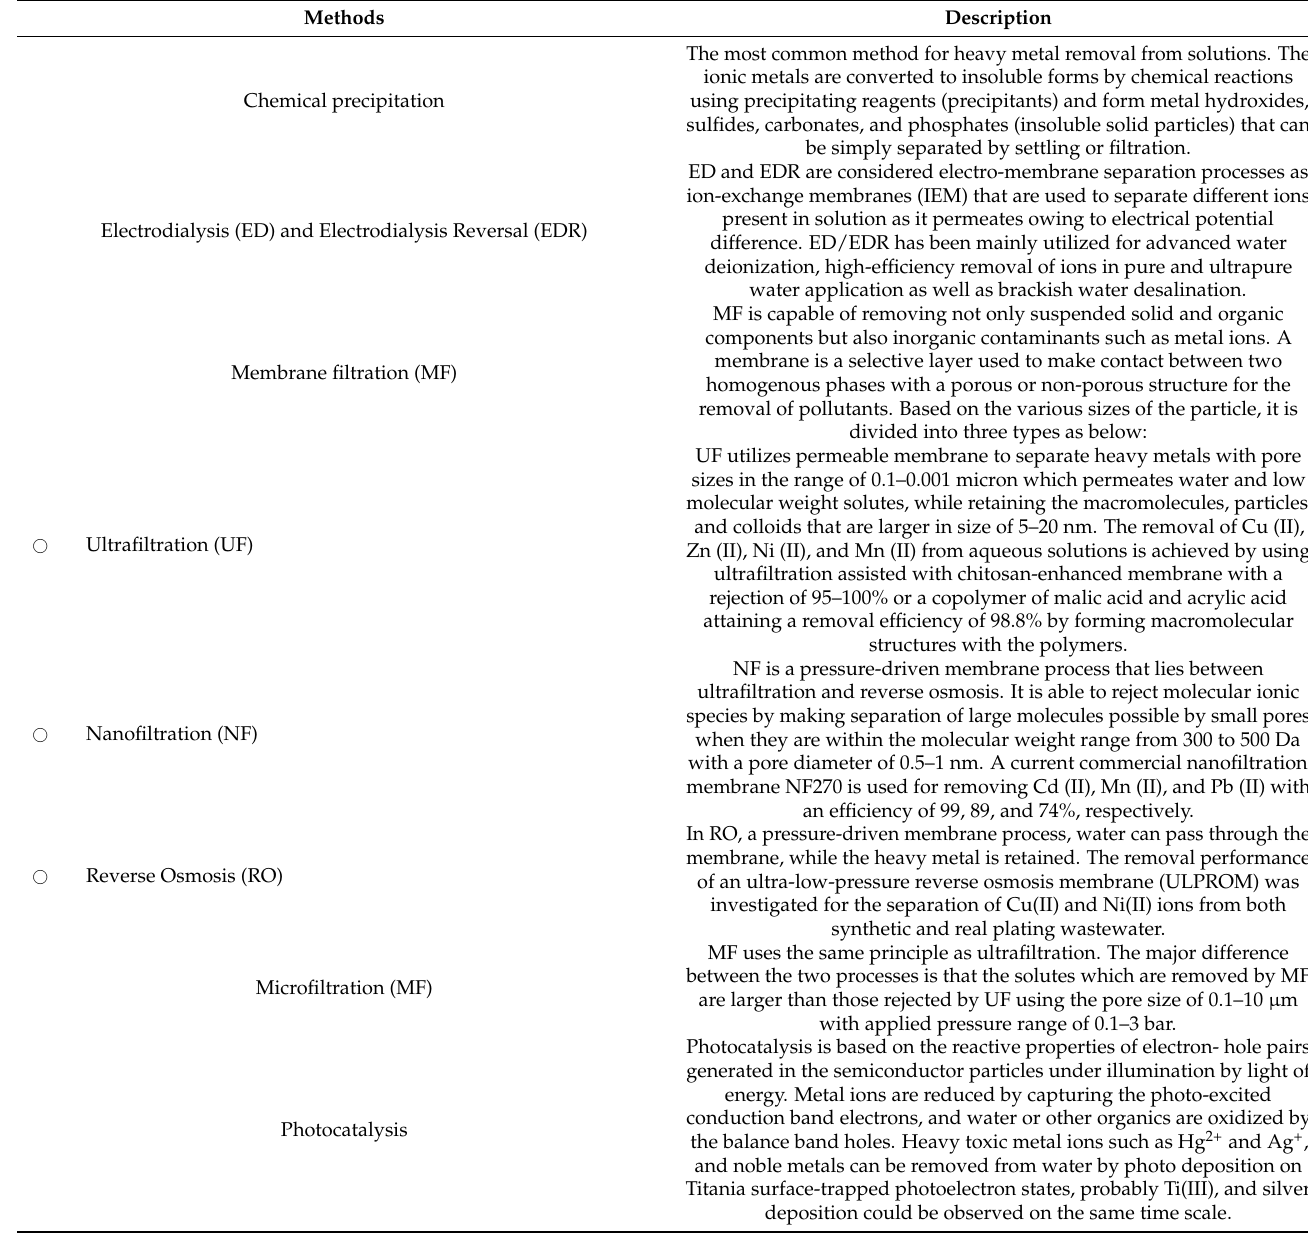
Table 1. Conventional methods for heavy metal